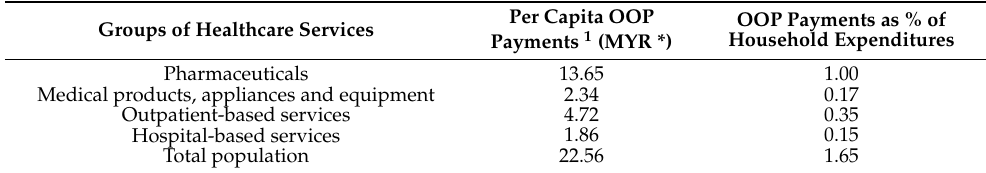
Table 3. Household expenditures and OOP payments by groups of healthcare services, Malaysia